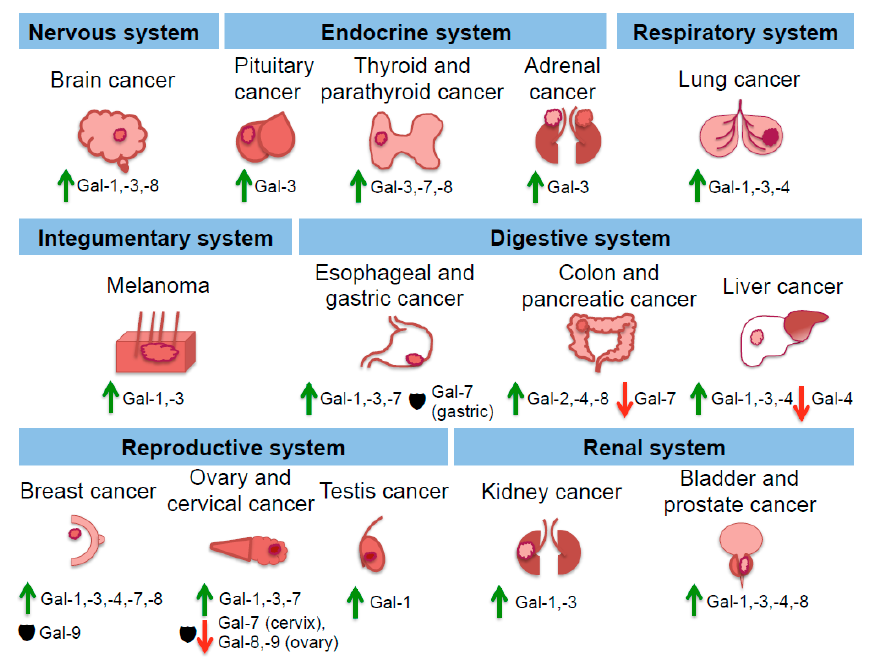
Figure 3. Involvement of galectins in organ ‐ specific carcinogenesis within different physiological systems. Various elevated galectin expression is associated with tumor progression (green arrow up). In some instances, low galectin expression is correlated with the generation of neoplastic tissue (red arrow down). Additionally, galectins can have potential protective roles (black shield) during carcinogenesis.